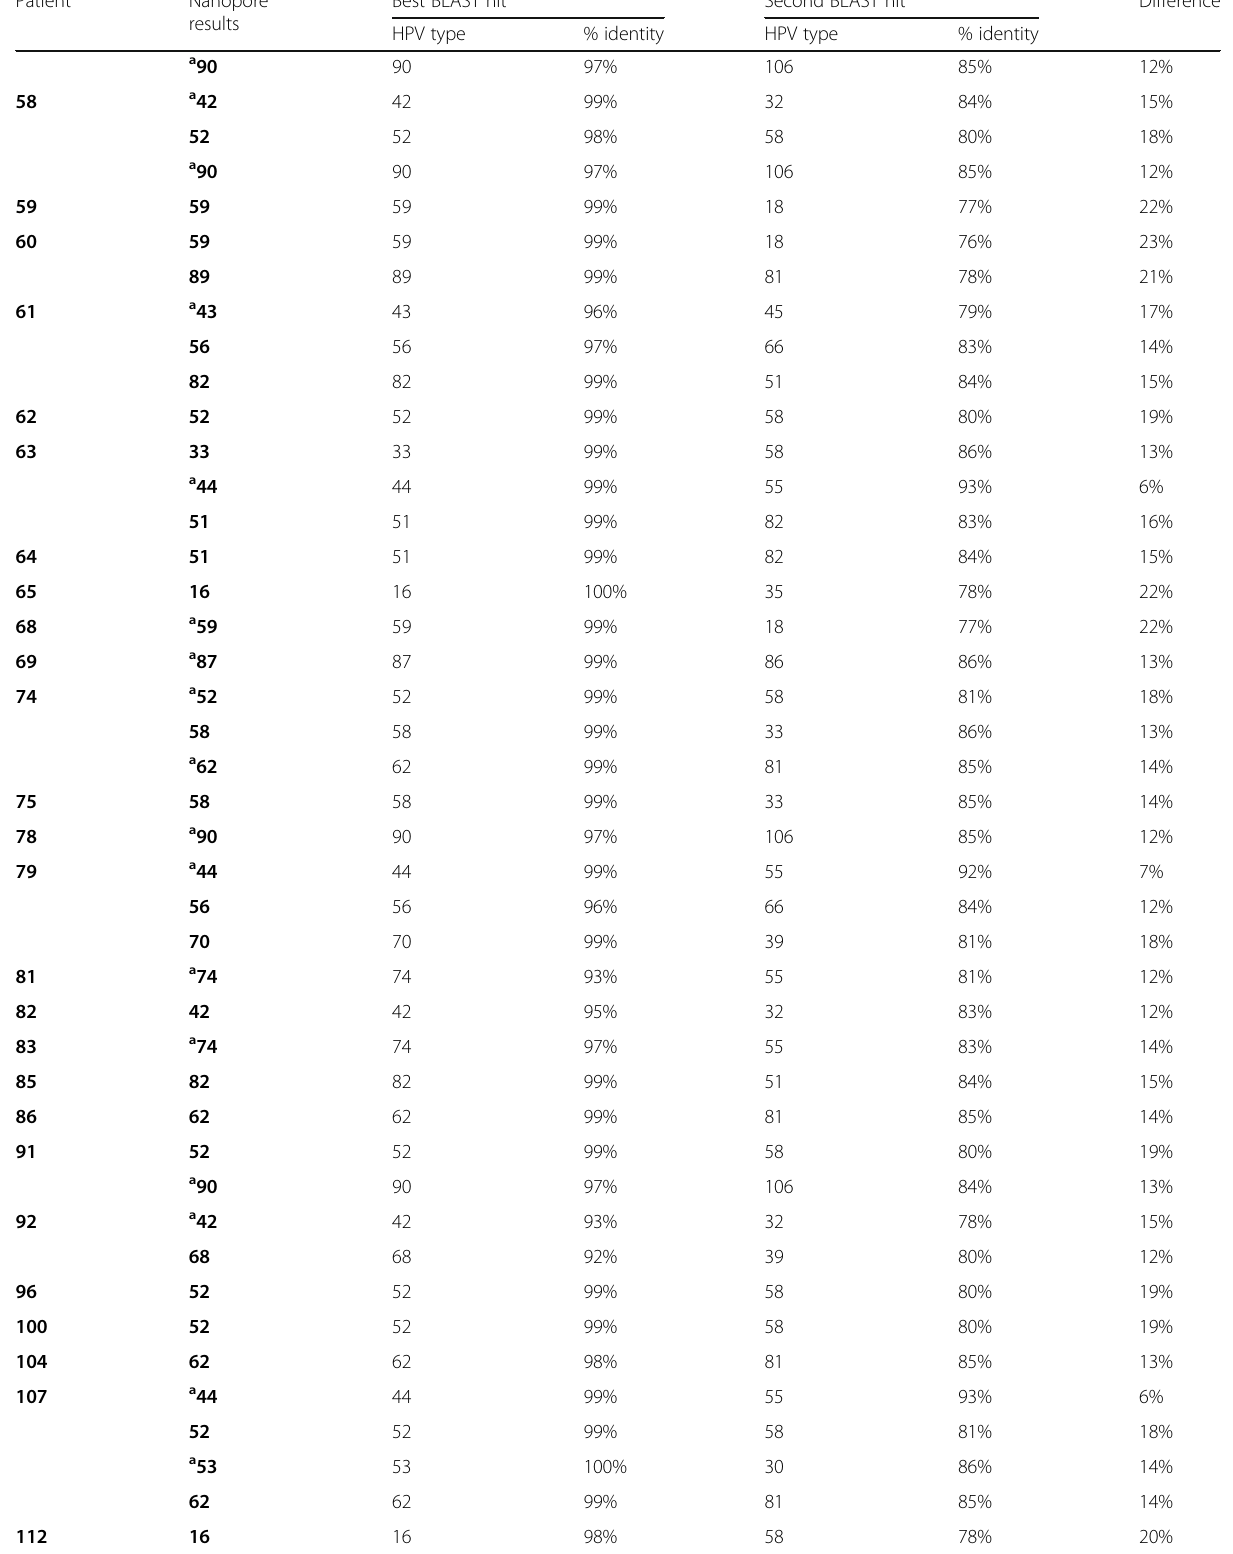
Table 7 Percentage of identity of Nanopore consensus sequences to HPV reference genomes (Continued)